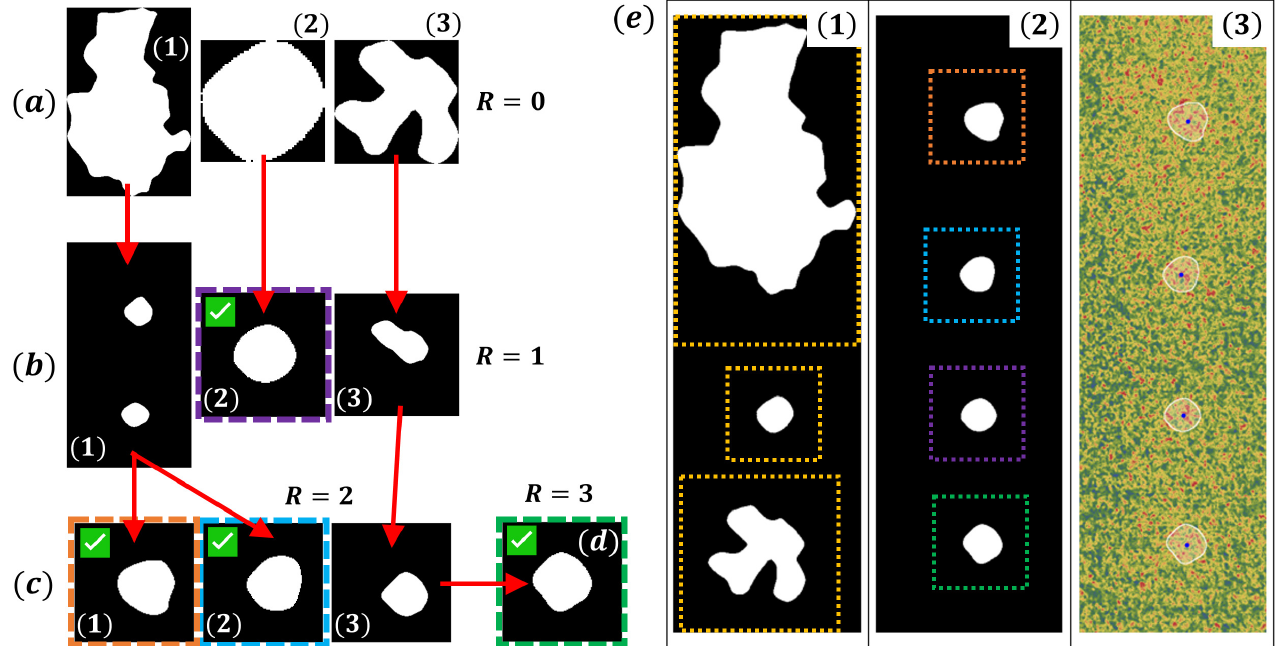
Figure 13. An illustration of the iterative interrogation process for an image with one of the worst overall SNR values, where R is the MRIF recursion depth. Sub-figures ( a – d ) show R running 0 through 3 for the segments detected at each depth. Sub-figure ( e ) displays (1) the initial segments, (2) MRIF output and (3) output overlays for the original image. Converged segments are flagged with green ticked boxes. Colored frames in ( e2 ) correspond to ( b2 ), ( c1–2 , d ) via respective colors. Orange frames in ( e1 ) indicate the IWs at R = 1: note the high aspect ratio of the topmost IW—its virtual counterpart is significantly out-of-bounds and therefore considerable crop correction (17) is assigned to properly map ( c1–2 ) onto the